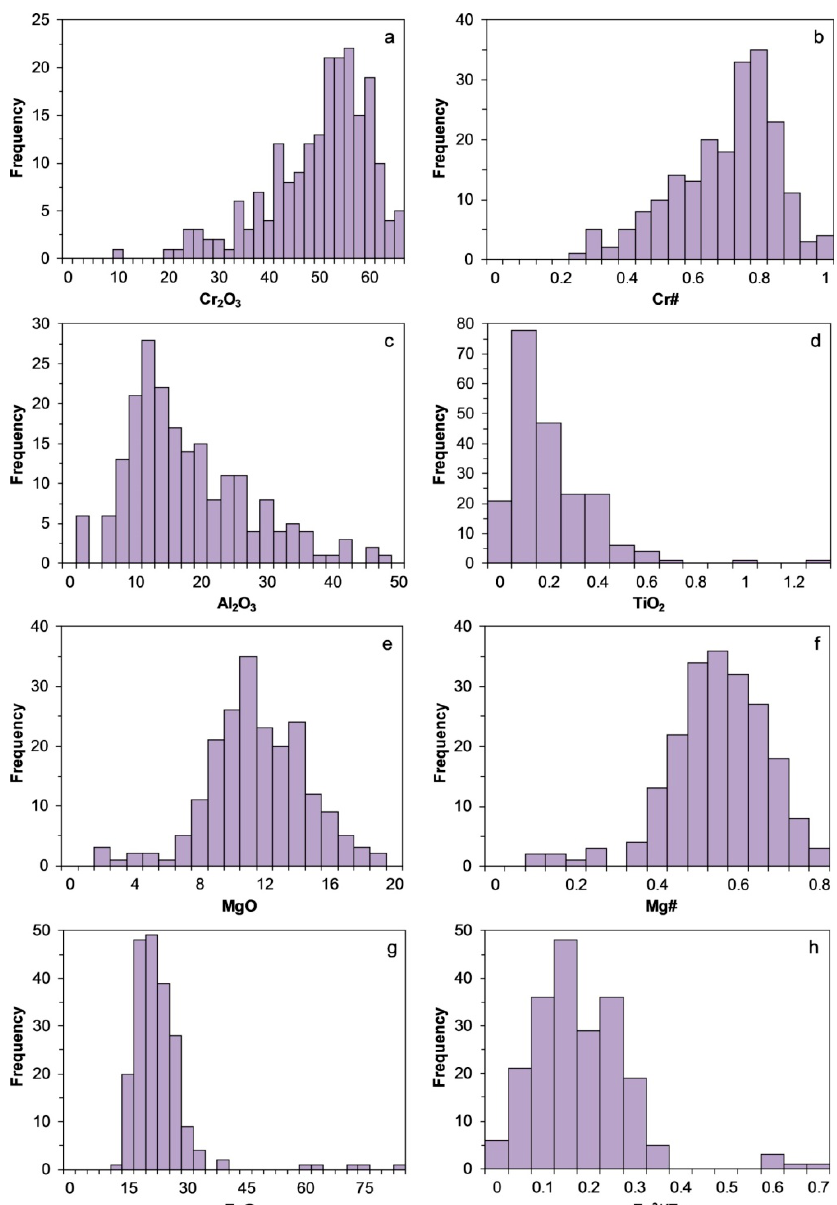
Figure 8. Histograms of the frequency distribution of the major components in chromspinels from the Sabantuy paleoplacer: ( a ) Cr 2 O 3 , ( b ) Cr# = Cr/(Cr + Al), ( c ) Al 2 O 3 , ( d ) TiO 2 , ( e ) MgO, ( f ) Mg# = Mg/(Mg + Fe 2+ ), ( g ) FeO, ( h ) Fe 3+ /Fe t . Note: Fe t = Fe 2+ + Fe 3+ .